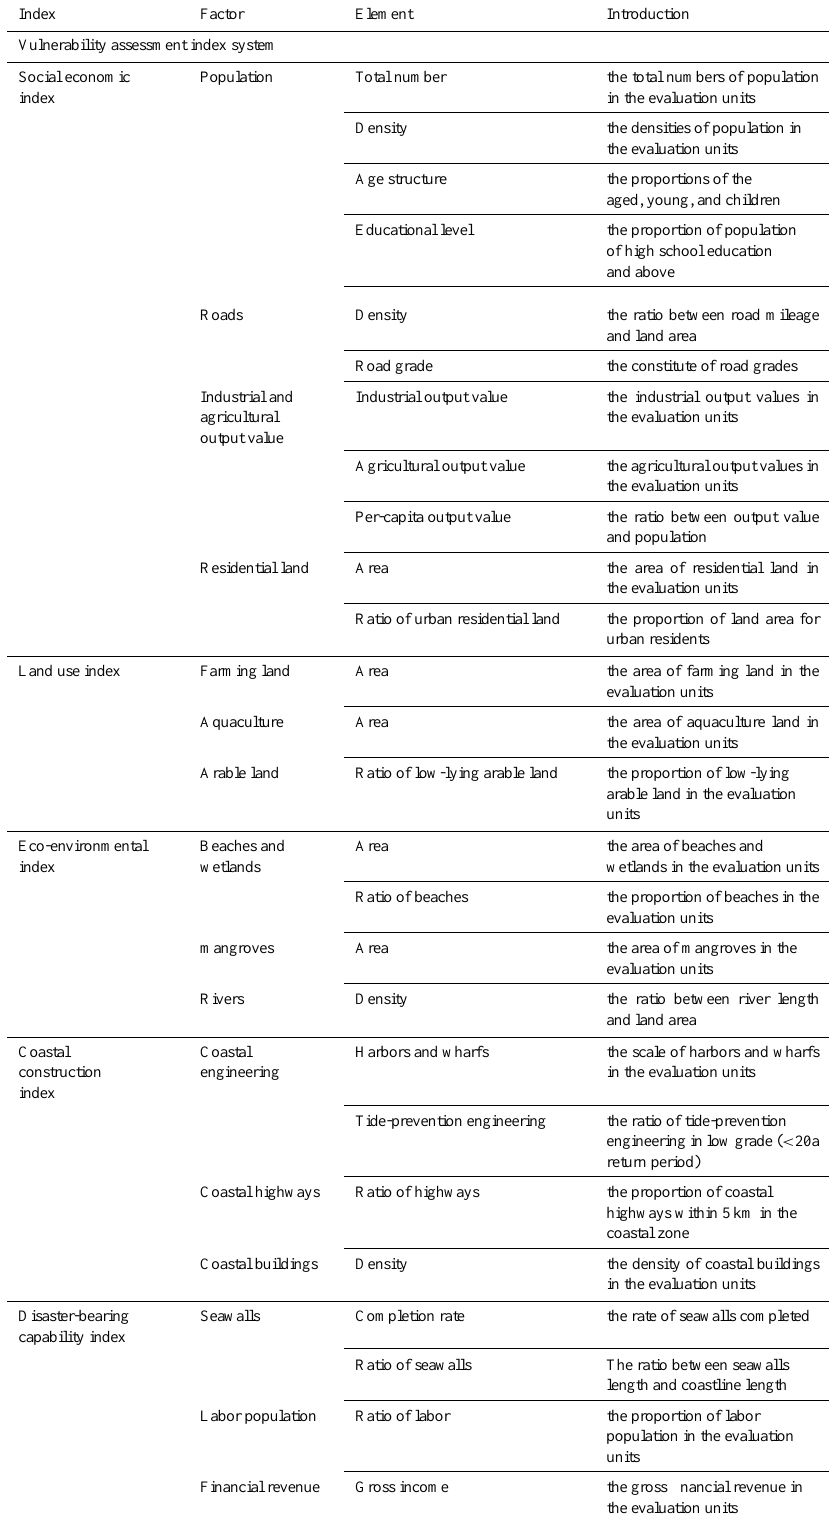
Table 1. Vulnerability assessment index system of storm surge